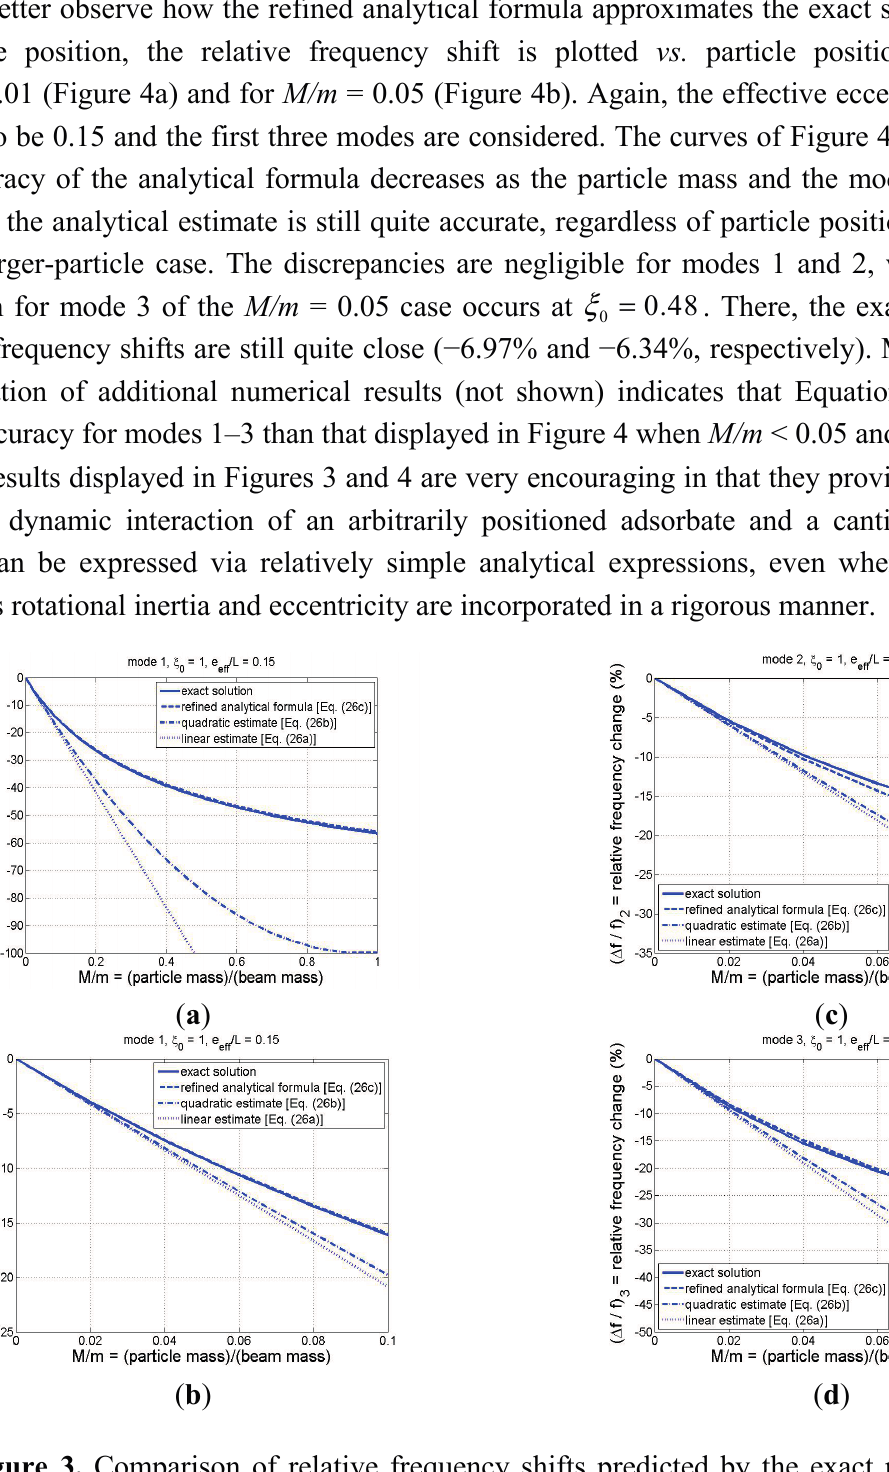
e = 0.15 and eff 0